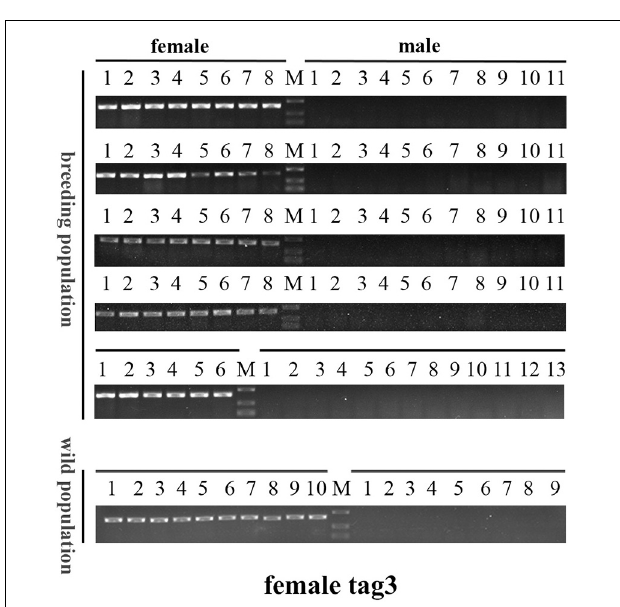
FIGURE 6 | Electrophoretogram of the amplified products using female-tag 3 for genotypic sex identification in M. nudus . Label M represents the DL2,000 DNA marker (500 and 250 bp DNA ladder are